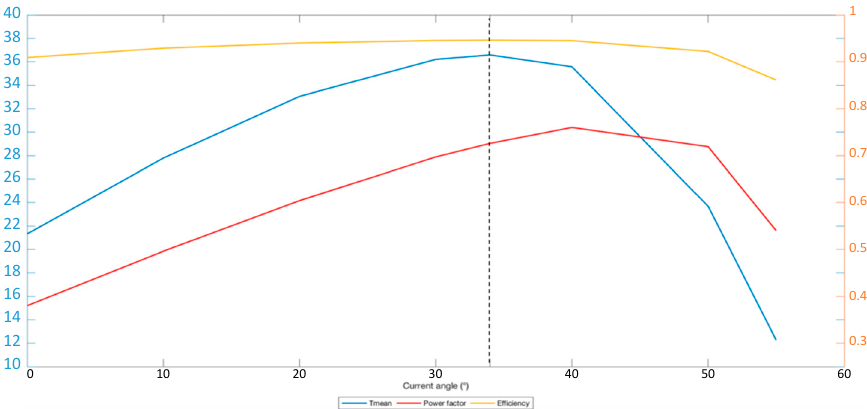
Figure 14. Current angle influence on average torque (expressed in N · m), power factor and efficiency.